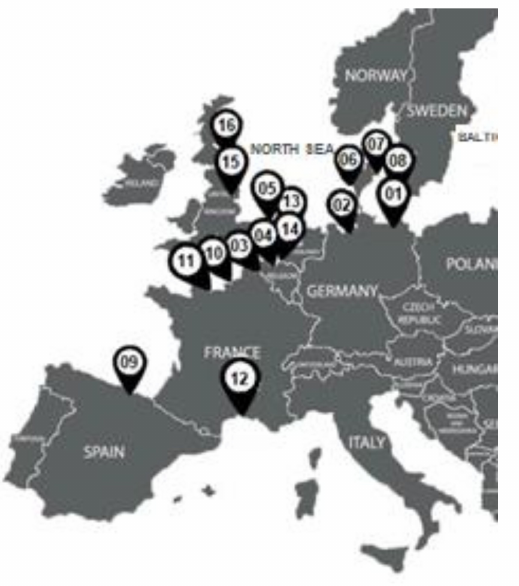
Figure 2. Map with the main seaports related to offshore wind energy in Europe. Legend : 1—Port of Rostock; 2—Port of Cuxhaven; 3—Port of Ostend; 4—Port of Zeebruge; 5—Port of Antwerp; 6—Port of Esbjerg; 7—Port of Grenaa; 8—Port of Rønne; 9—Port of Bilbao; 10—Port of Dieppe; 11—Port of Le Havre; 12—Port of Fos Sur Mer; 13—Port of Amsterdam; 14—Port of Vlissingen; 15—Green Port Hull; 16—Port of